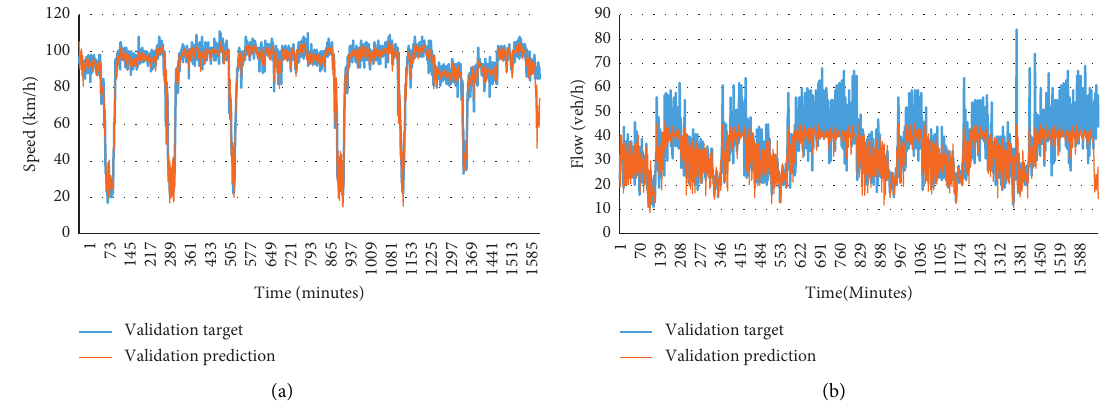
Figure 13: Speed and flow validation results for 15 minutes.